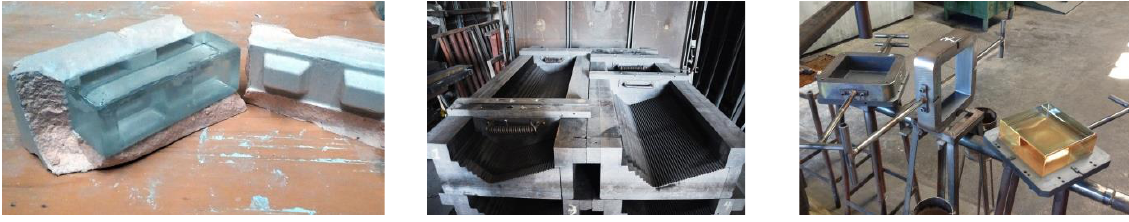
Fig. 5 From left to right: disposable low-precision mould, adjustable and open high-precision metal moulds.